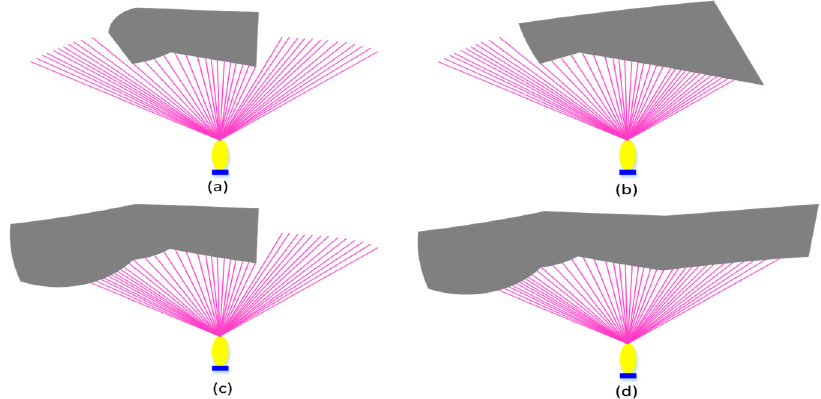
Figure 4. Obstacle classification. ( a ) Bounded obstacle. ( b ) Left bounded obstacle. ( c ) Right bounded obstacle. ( d ) Unbounded obstacle.